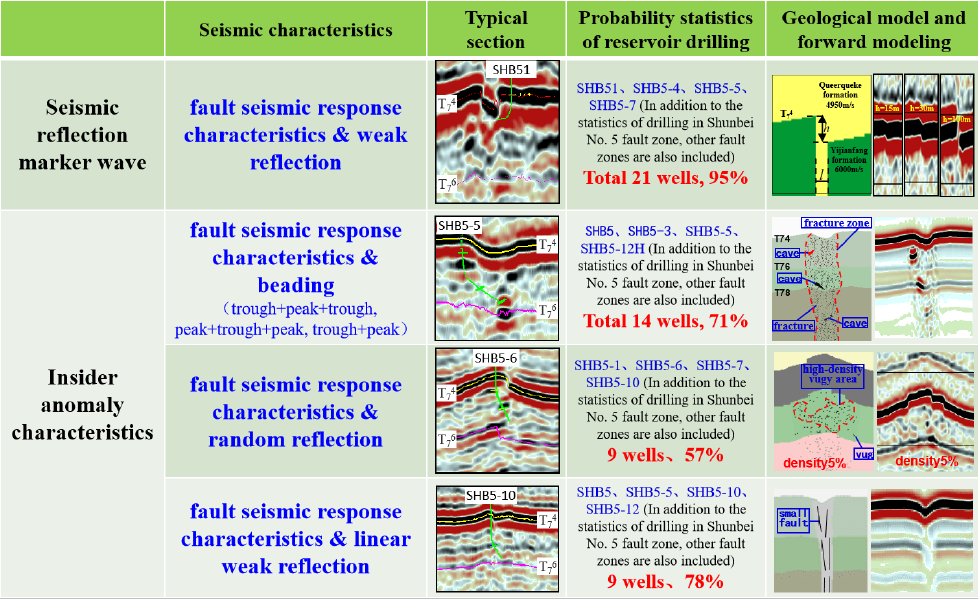
Figure 14. A seismic identification model of a fault-controlled reservoir in the Shunbei area.